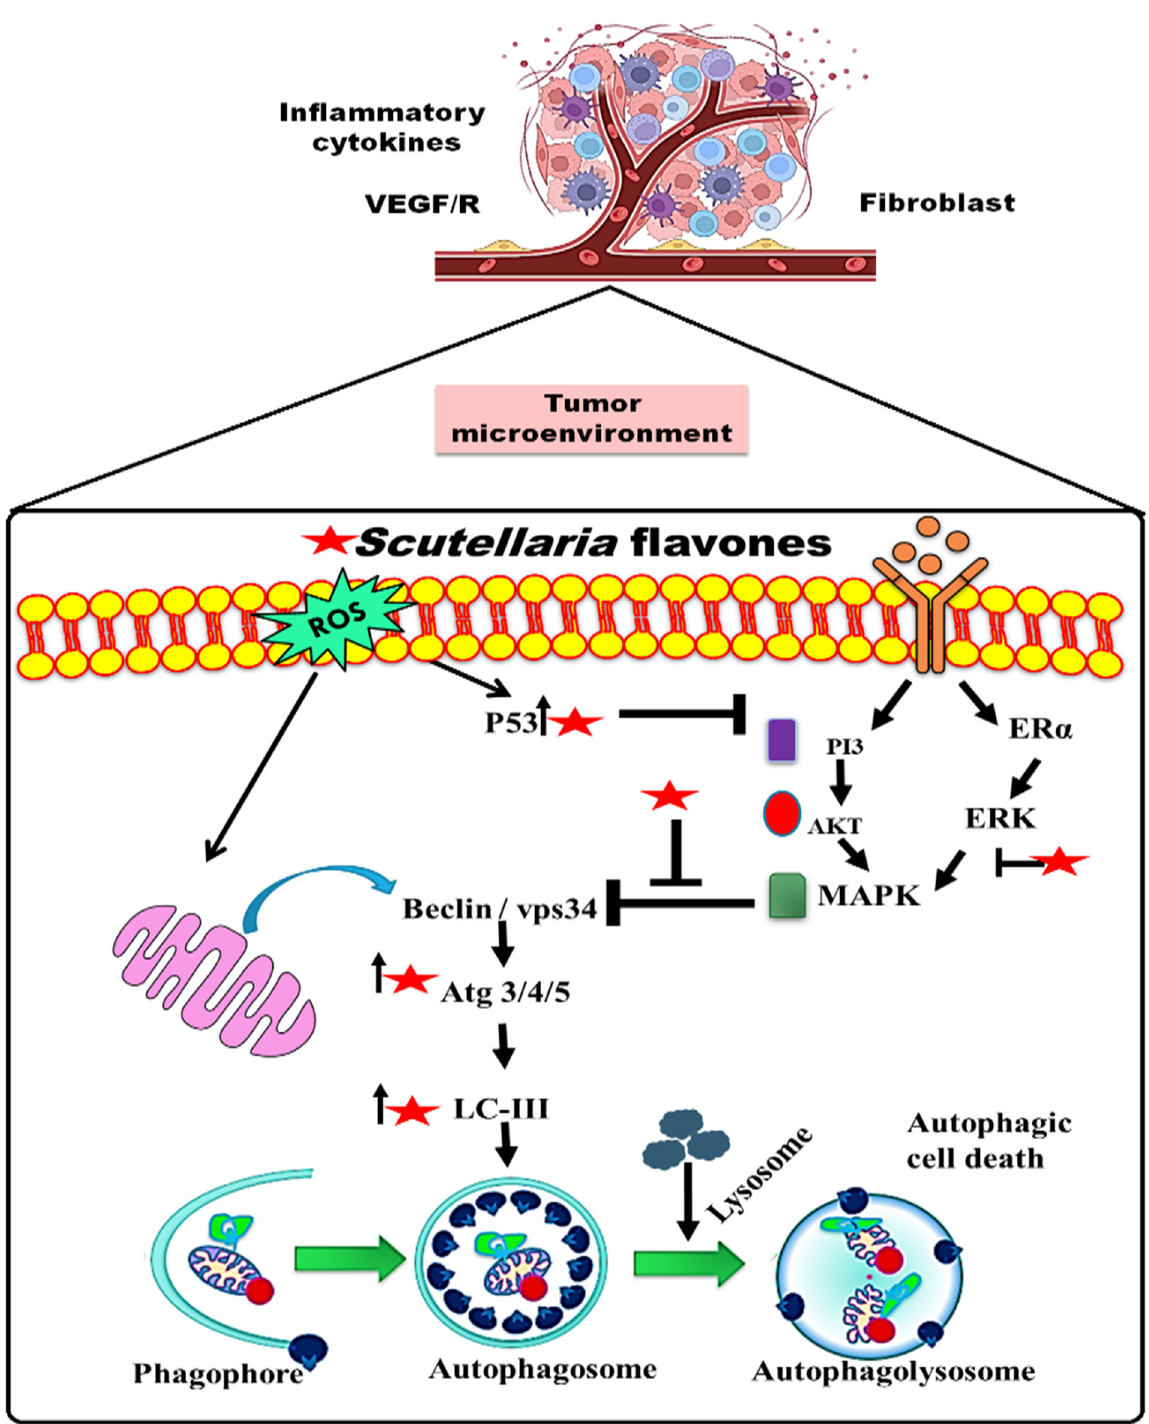
Figure 2. Schematic diagram showing the role of Scutellaria flavonoes in the tumor